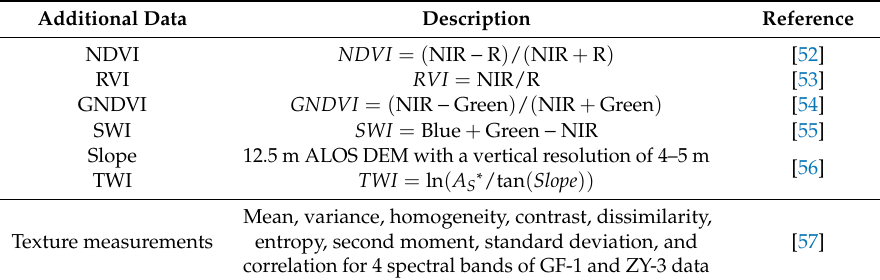
Table 4. Training and testing sample size for GF-1 and